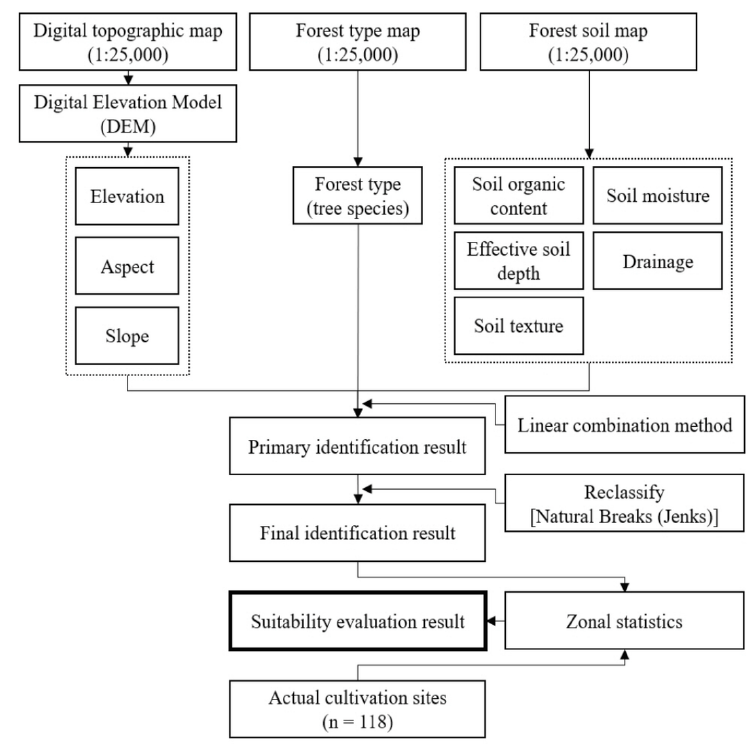
Figure 2. Flow diagram of the process followed in this study.